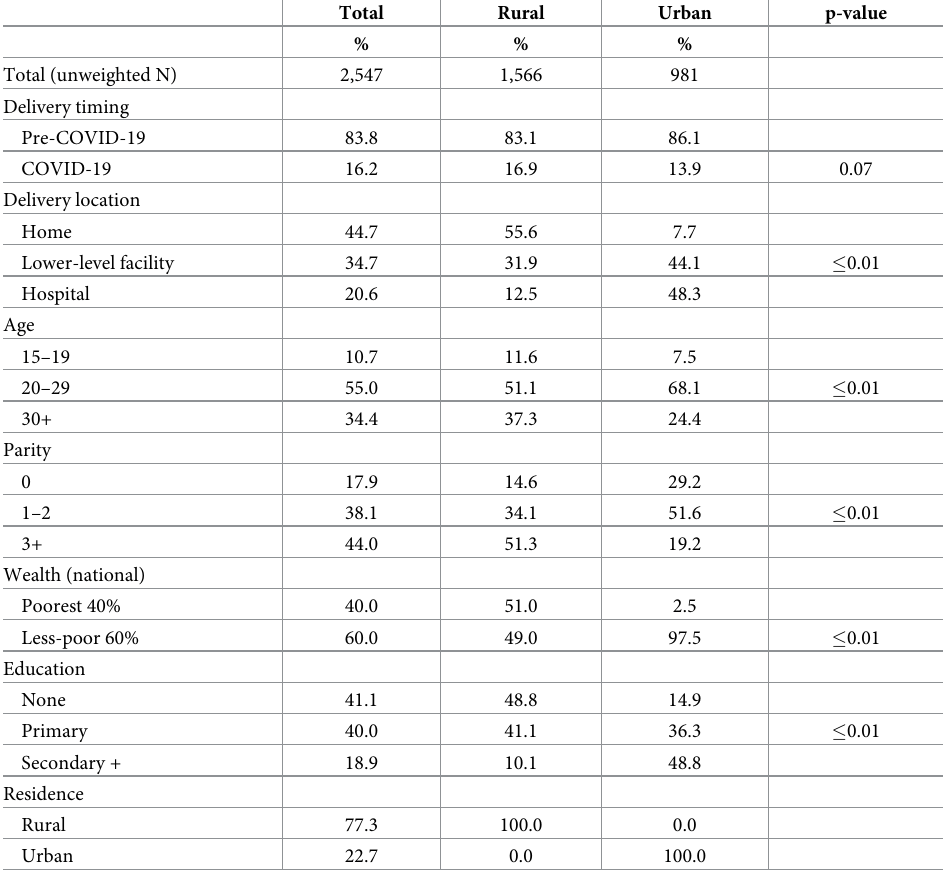
Table 1. Sample characteristics of all women in PMA Ethiopia who completed six-week questionnaire. Total Rural Urban p-value %